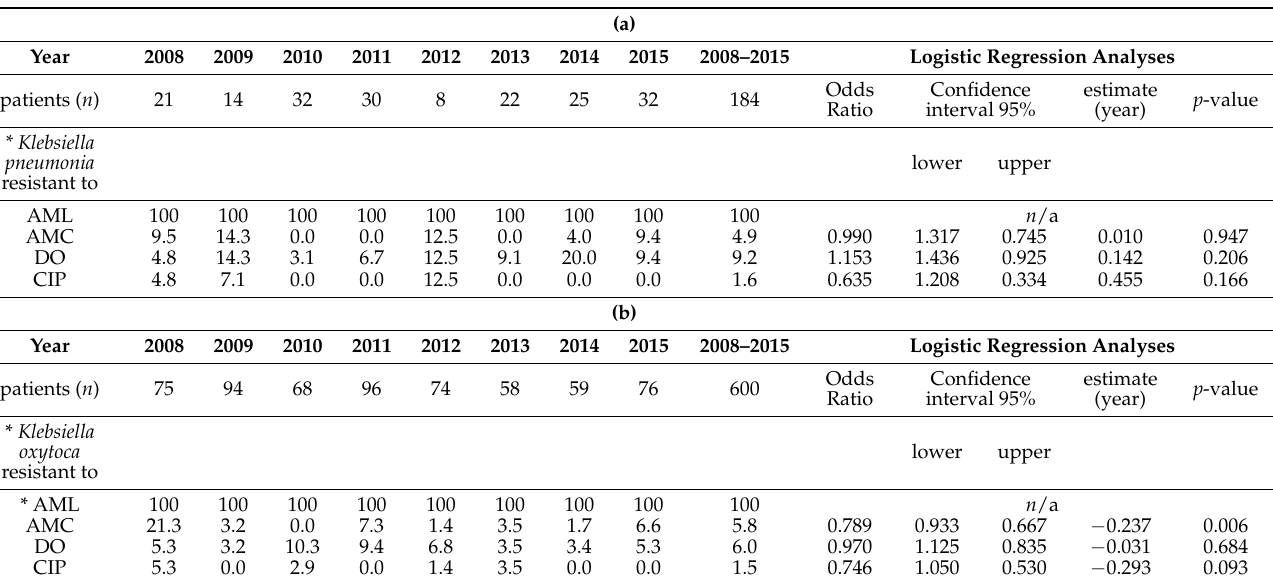
Table 3. ( a ) Temporal evolution (2008 to 2015) of the occurrence of antibiotic resistances to amoxicillin (AML), amoxicillin/clavulanic acid (AMC), doxycycline (DO), ciprofloxacin (CIP) was analyzed using logistic regression methods. Trend in the occurrence of antibiotic resistances (%) in * Klebsiella pneumoniae. ( b ) Temporal evolution (2008 to 2015) of the occurrence of antibiotic resistances to amoxicillin (AML), amoxicillin/clavulanic acid (AMC), doxycycline (DO), ciprofloxacin (CIP) was analyzed using logistic regression methods. Trend in the occurrence of antibiotic resistances (%) in * Klebsiella oxytoca .